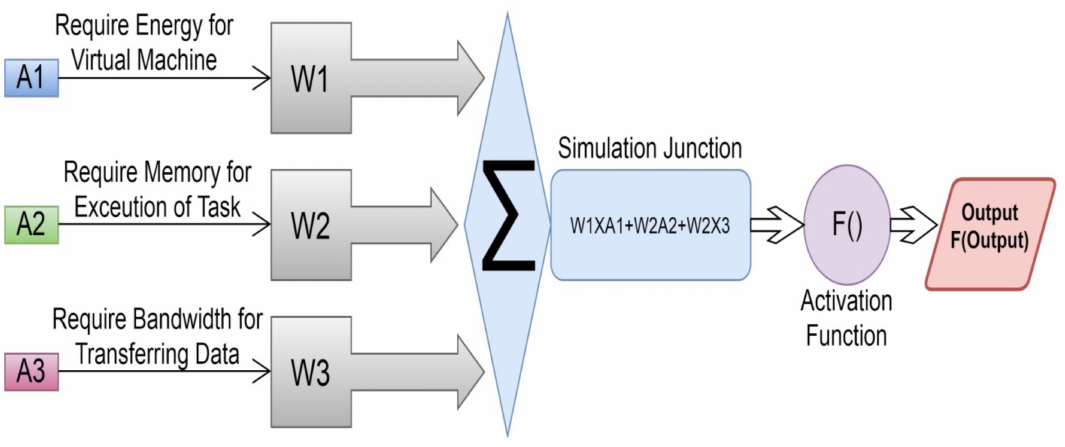
Figure 7. ANN Architecture.